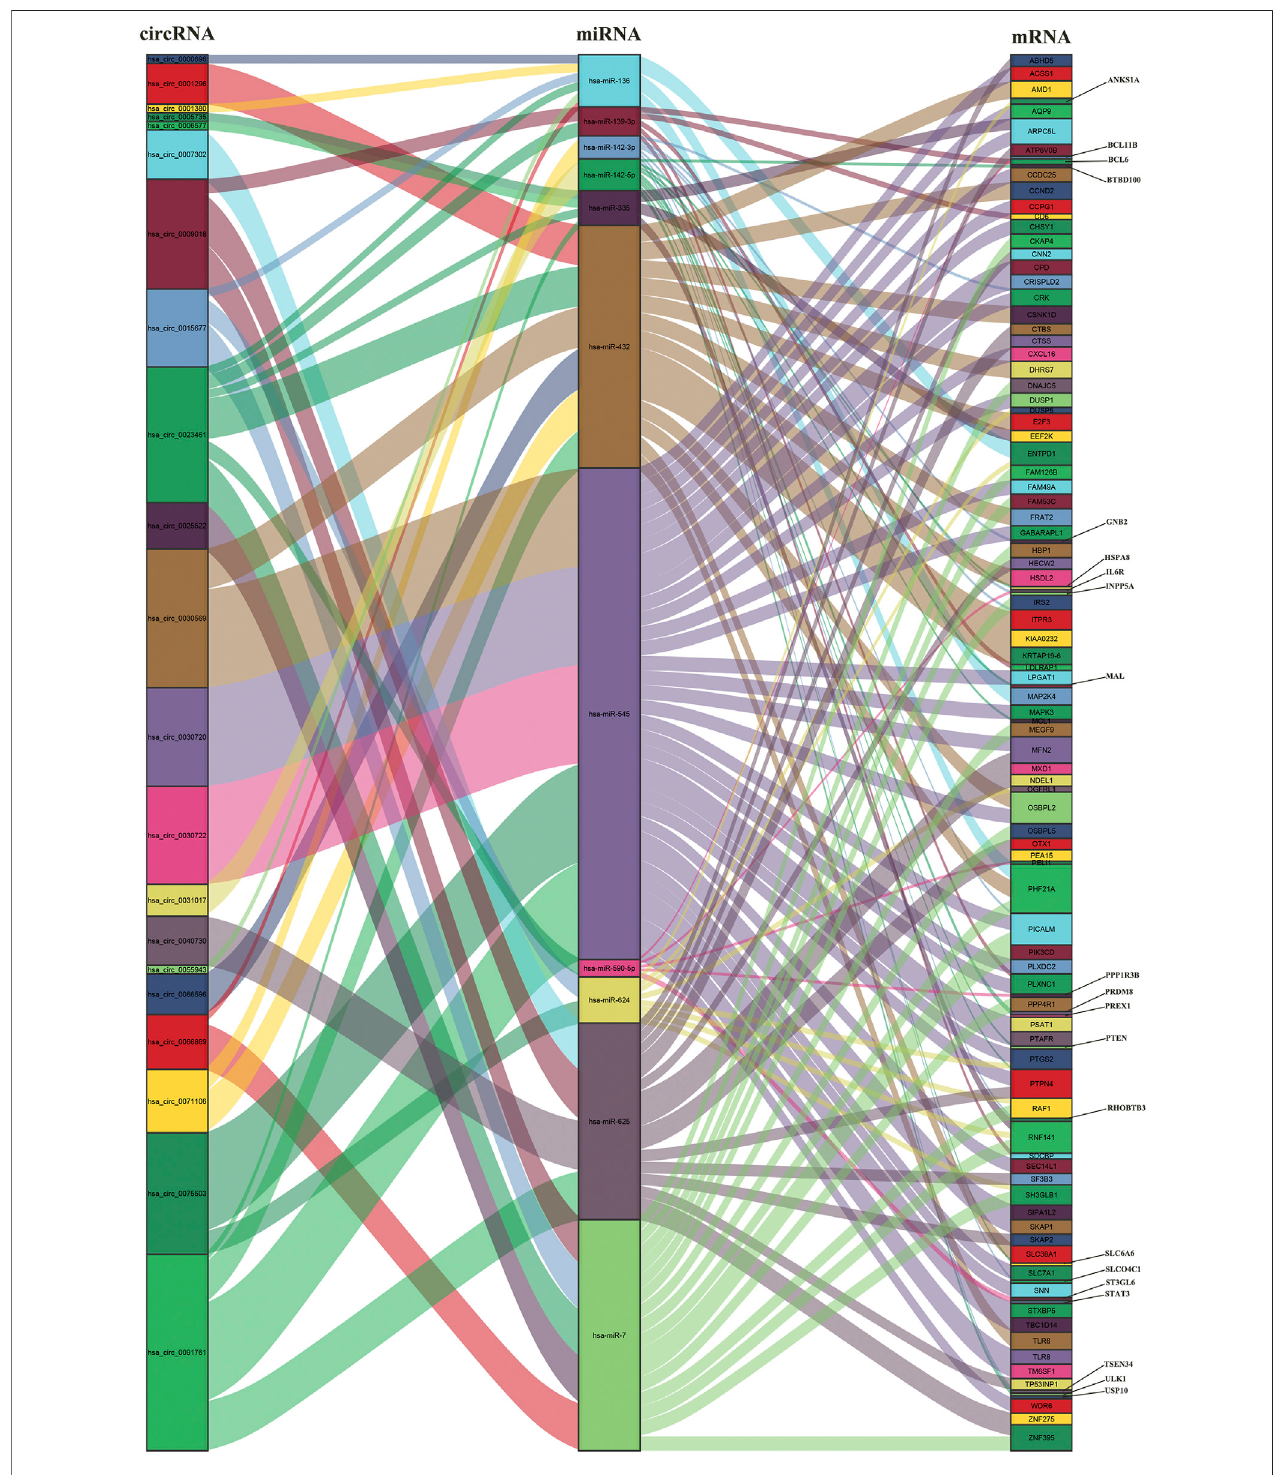
FIGURE 3 | Sankey diagram of the ceRNA network in AMI. The squareness represents circRNAs, miRNAs and mRNAs, and the size indicates their degree of connection.